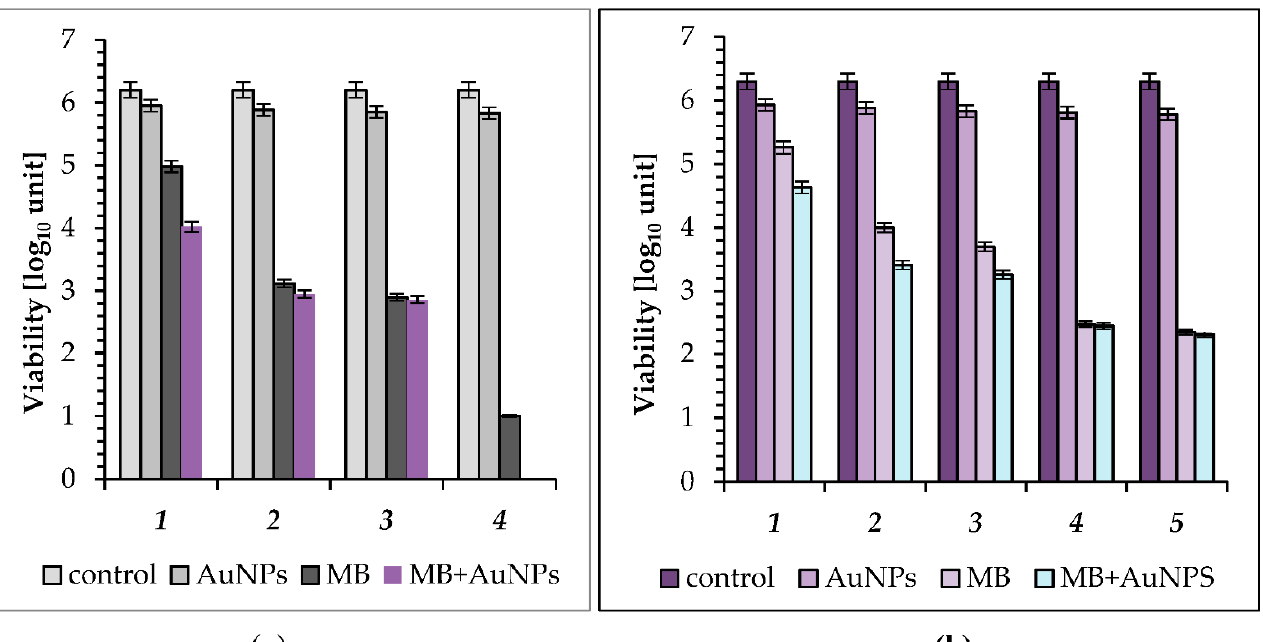
Figure 4. ( a ) Effect of AuNPs (gold nanoparticles), MB (methylene blue), and the MB + AuNP (methylene blue-gold nanoparticle mixture) on viability of: S. aureus following incubation in the dark: ( 1 ) exposure to LED light for 5 min (energy fluence was 3 J cm − 2 ); ( 2 ) 15 min (energy fluence was 9 J cm − 2 ); ( 3 ) 30 min (energy fluence was 18 J cm − 2 ); ( 4 ) and 45 min (energy fluence was 27 J cm − 2 ). ( b ) E. coli following incubation in the dark: ( 1 ) exposure to LED light for 5 min (energy fluence was 3 J cm − 2 ); ( 2 ) 15 min (energy fluence was 9 J cm − 2 ); ( 3 ) 30 min (energy fluence was 18 J cm − 2 ); ( 4 ) 45 min (energy fluence was 27 J cm − 2 ); and ( 5 ) 60 min (energy fluence was 36 J cm − 2 ); (in all groups p < 0.05); the control is the initial concentration of bacteria in suspensions kept in the dark.